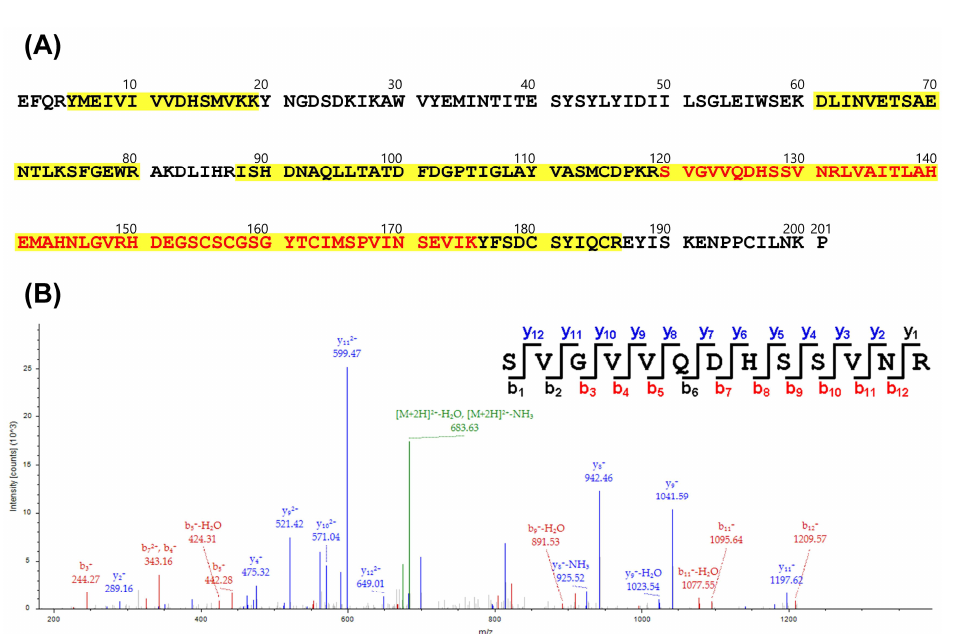
Figure 5. Identification of acutolysin A by LC–MS/MS analysis. ( A ) The positions of identified pep- tides were indicated in the full-length sequence of acutolysin A, and the unique peptides are denoted in red. ( B ) The MS/MS spectrum presents the identification of unique peptide SVGVVQDHSSVNR.